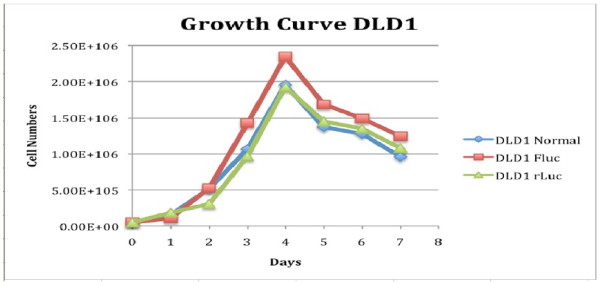
Above showing growth curve of Normal DLD1, DLD1/SV-FLuc, rLuc cells over the period of seven days. Cells were maintained in 10 ml RPMI supplemented with 1% L-glutamine, 1% Sodium Pyruvate, and 5% Fetal bovine syrup (FBS), incubated at 37°C 5% CO2. Counted manually using haemocytometer. Results were measured (mean ± s.d).